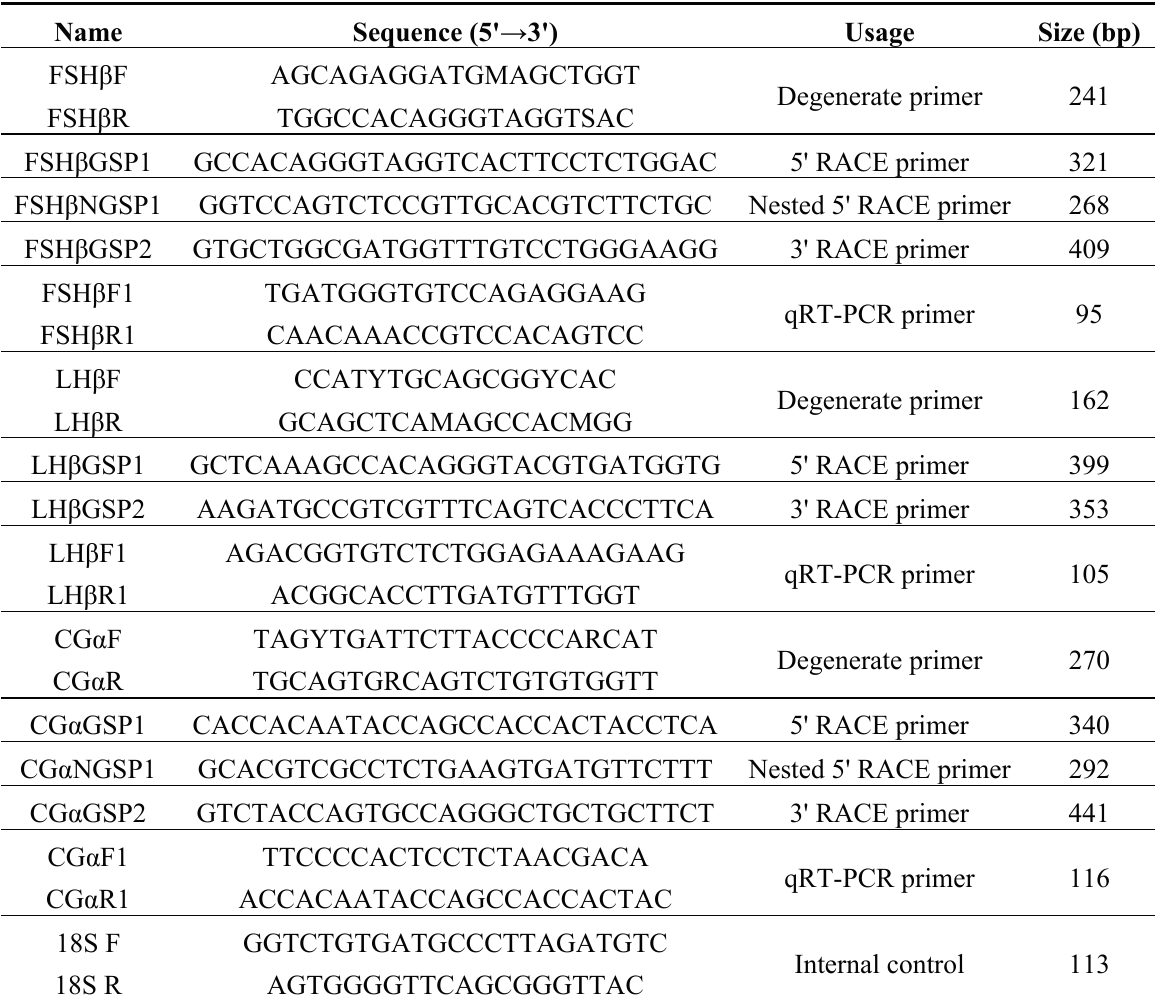
Table 1. The primer sequences used in the present